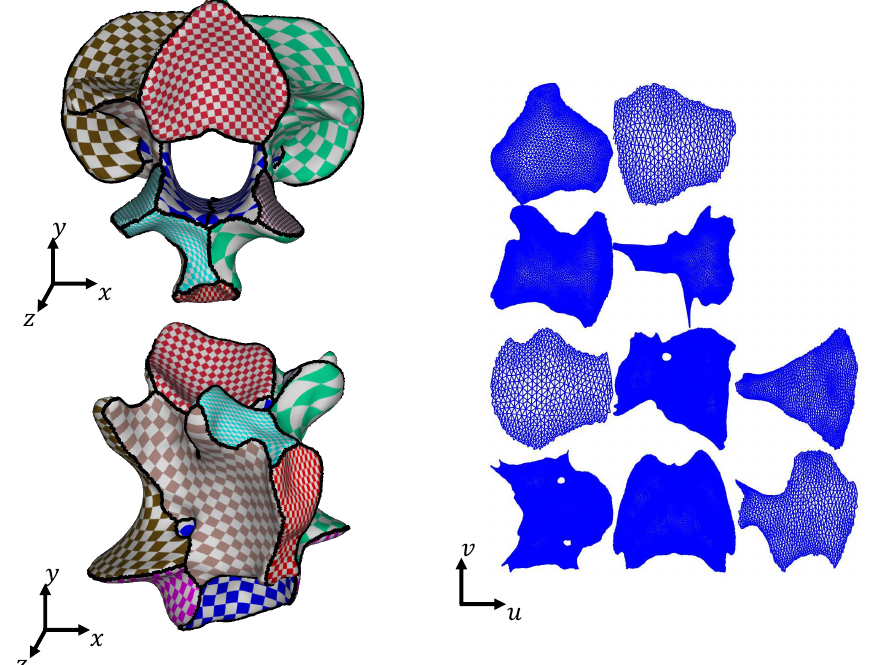
Figure 14. Cow Vertebra data set. Undistorted parameterization using heat-based geodesic maps. Segmentation by Mejia et al.